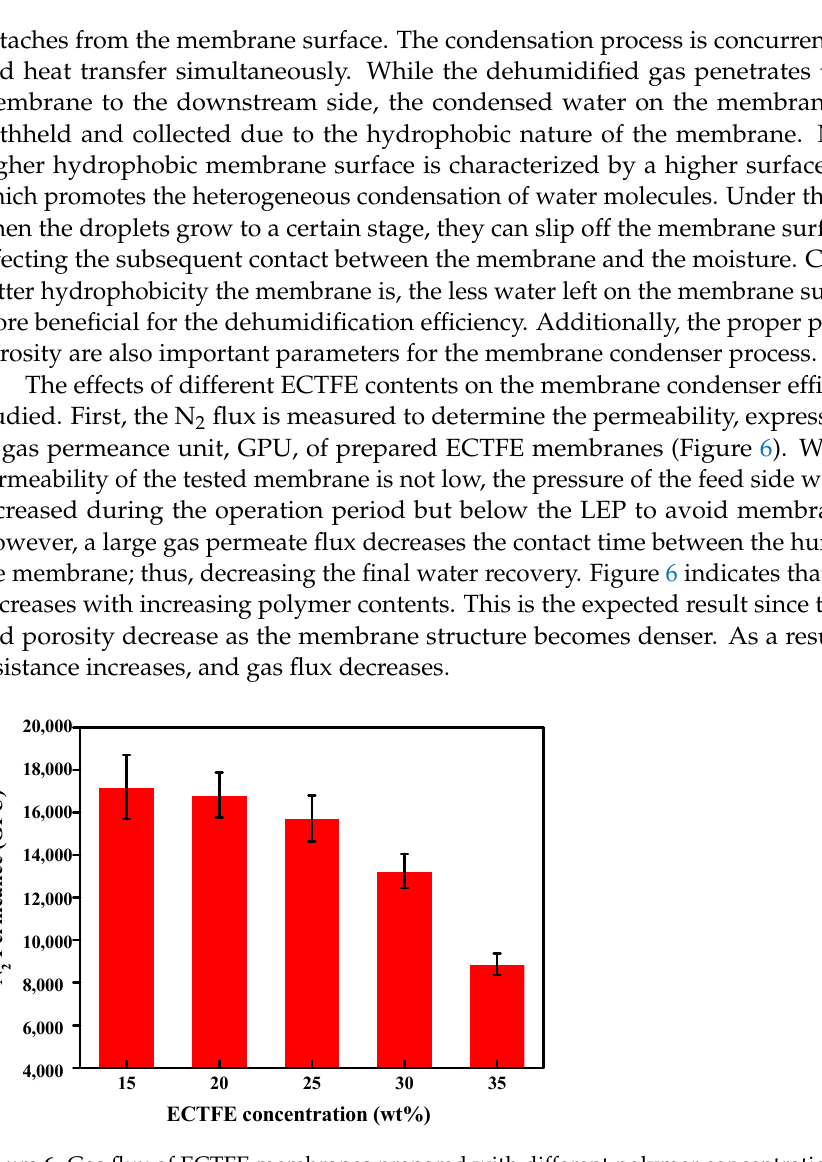
Figure 6. Gas flux of ECTFE membranes prepared with different polymer concentrations.